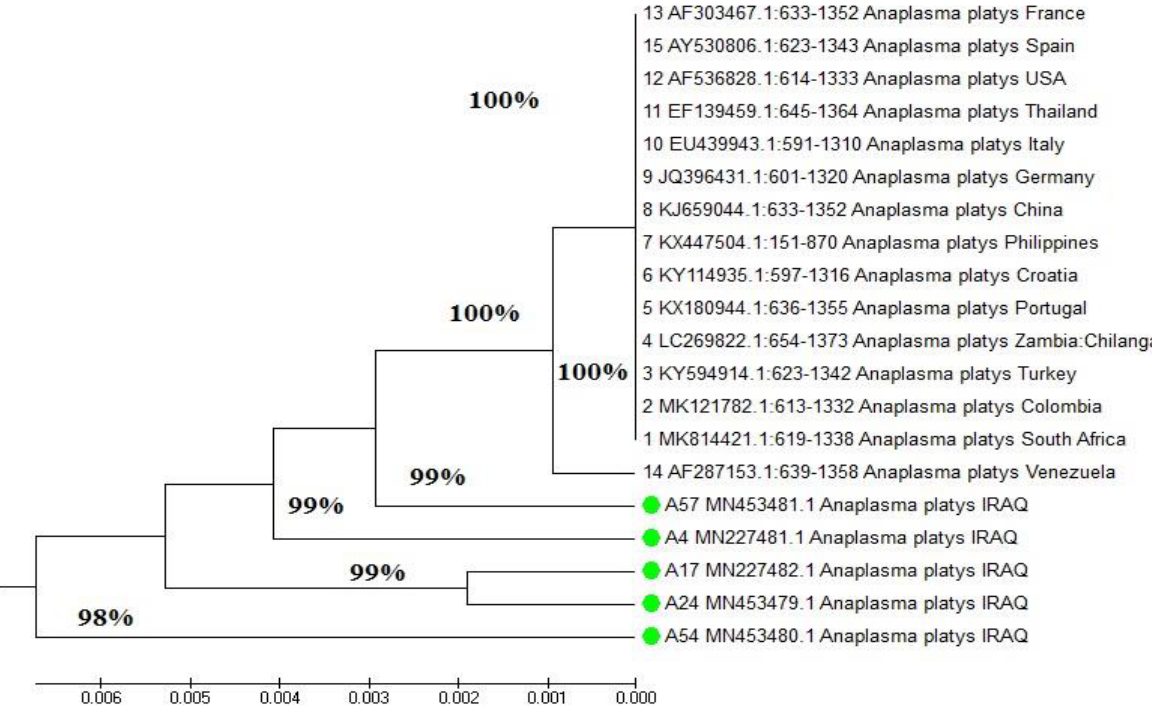
Figure 4. Neighbor-joining tree of A. platys using the 16S rRNA gene. The above gene of A. platys in the Iraqi isolates is represented by green circles compared with that of the 15 related strains deposited in the